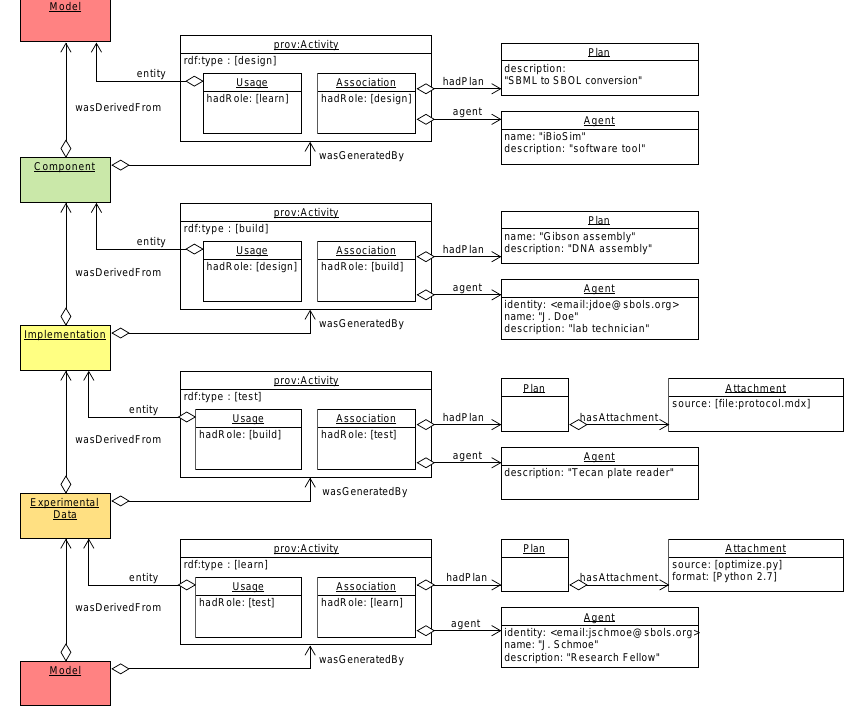
Figure 28: An example data structure representing an idealized workflow for model-based design.